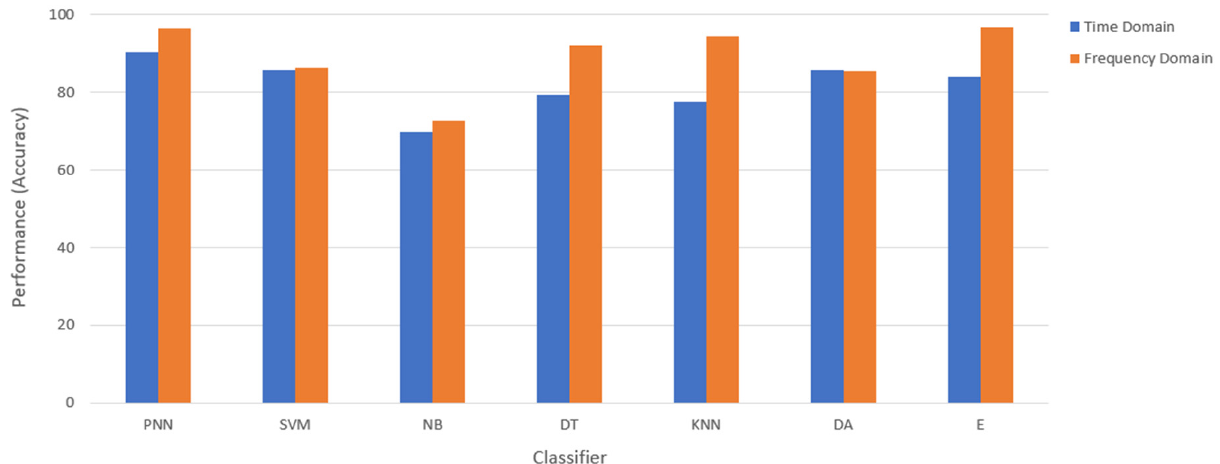
Figure 8. Comparison results between the time and frequency domain after feature normalization and feature dimension reduction.